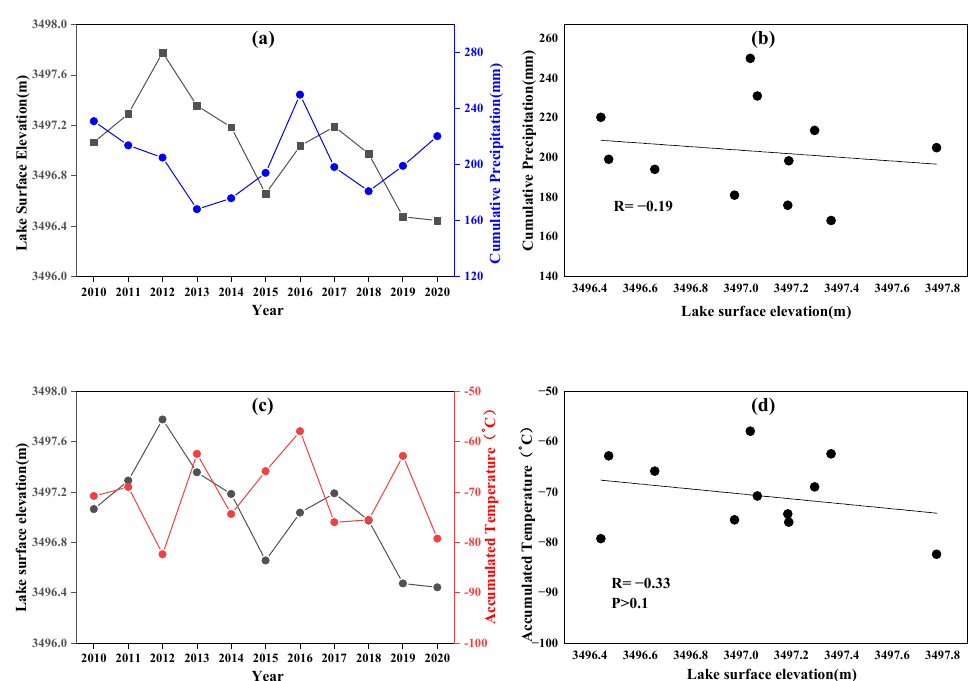
Figure 9. ( a ) Annual cumulative precipitation and lake surface elevation curves for Lake Chatyrkul. ( b ) Correlation between cumulative precipitation and lake surface elevation. ( c ) Annual cumulative temperature and lake surface elevation curves of Lake Chatyrkul. ( d ) Correlation between cumulative temperature and lake surface elevation.